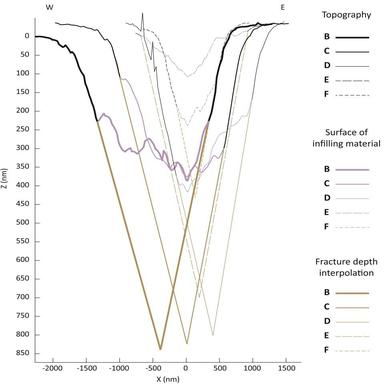
Interpolation of infilled crack profiles on RN02 to retrieve an estimate of true fracture depth, assuming that the crack walls have constant structural slope. The pyroxene surface and the interpreted observed crack surface are in black, the interpreted infilling surface in violet, and the interpolated crack wall in beige. (For interpretation of the references to colour in this figure legend, the reader is referred to the Web version of this article.)